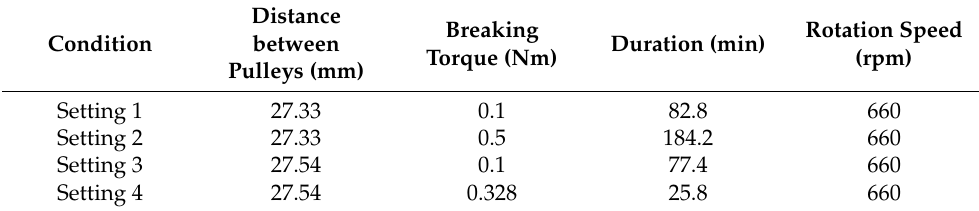
Table 3. Operating conditions implemented during the Testing phase .